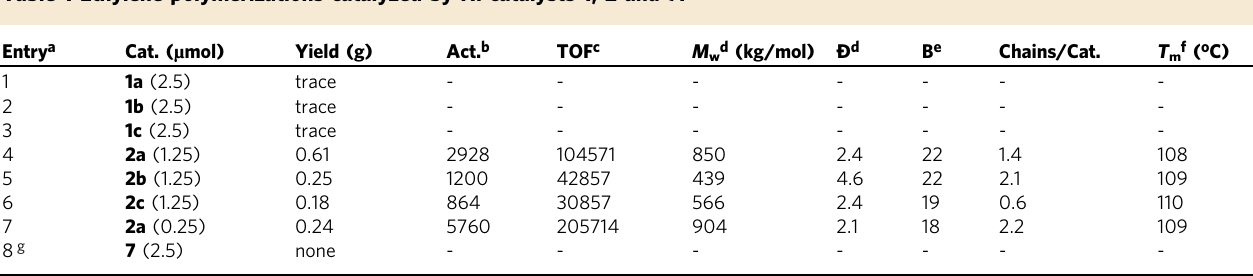
Fig. 1 Structure formula and single crystal structures of catalysts. a Synthesis of tetranuclear nickel complexes 2a - 2c . b Single crystal structures of complexes 2a and 2c . c Literature reported nickel complexes 3 , 4 and 5 . d Synthesis of complex 7 . e Single crystal structure of complex 7 . Table 1 Ethylene polymerizations catalyzed by Ni catalysts 1, 2 and